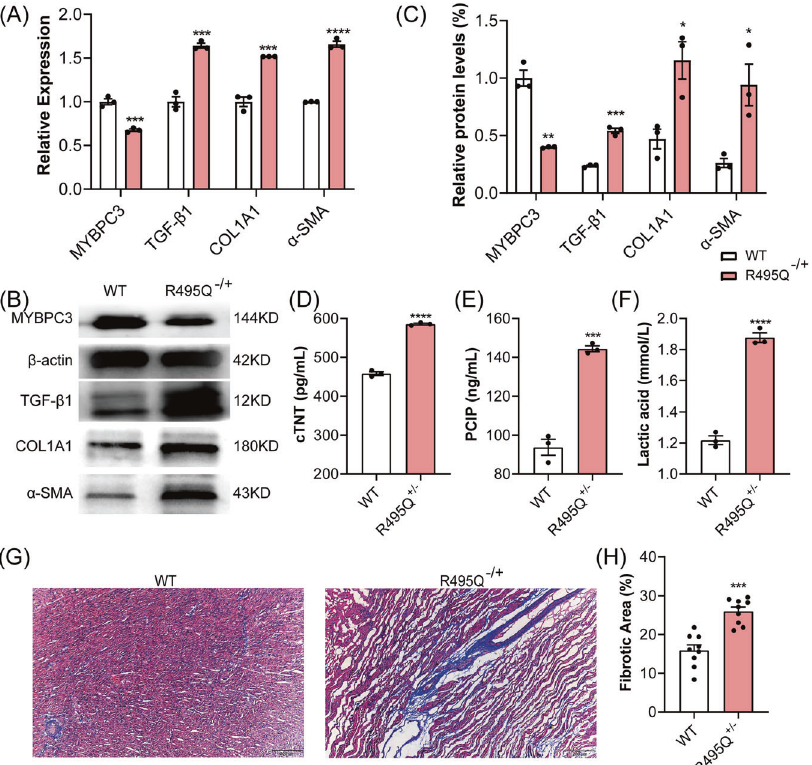
Fig. 1 MYBPC3-R495Q + / − pigs developed severe myocardial fi brosis, concomitant with reduced MYBPC3 gene expression and elevated lactic acid concentrations. A – C The transcript ( A ) and protein ( B , C ) expression levels of MYBPC3, TGF- β 1, COL1A1, and α -SMA in MYBPC3- R495Q + / − pigs and the age-matched wild-type pigs. *** P < 0.001. D – F Measurements of serum cTNT ( D ), PCIP ( E ), and lactic acid ( F ) in WT and MYBPC3-R495Q + / − pigs. *** P < 0.001; **** P < 0.0001. G , H Masson trichrome staining and quanti fi cation of cardiac fi brosis in WT and MYBPC3- R495Q + / − pigs. *** P < 0.001. N = 3 per